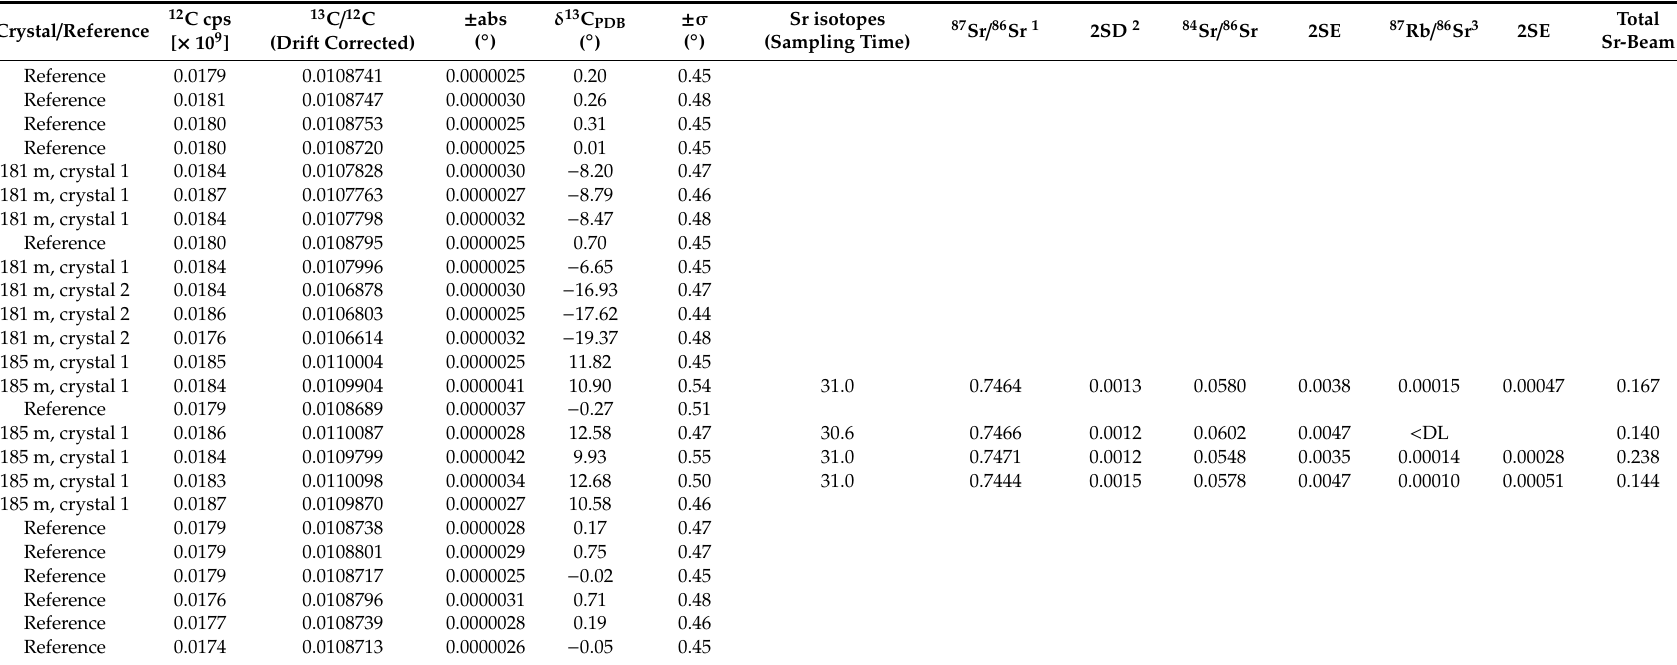
Table 2. SIMS and laser ablation multi-collector inductively coupled plasma mass spectrometry (LA-MC-ICP-MS) data for calcite. SIMS-analyses of δ 13 C in calcite in samples 181 and 185 m and LA-MC-ICP-MS-analyses of 87 Sr / 86 Sr in sample 185 m. Sample and reference material, in analytical sequence (SIMS). Reference materials for 87 Sr / 86 Sr are listed in table below. SD = Standard deviation, SE = Standard